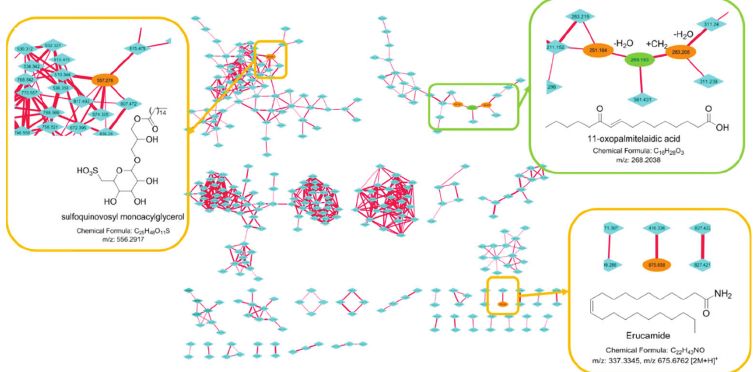
Figure 5. LC-HRMS / MS molecular network of the cyanobacterium Leibleinia gracilis built using GNPS with cosine similarity score cuto ff 0.65. In green, the compound is isolated, and in orange, the compounds are assigned using databases or